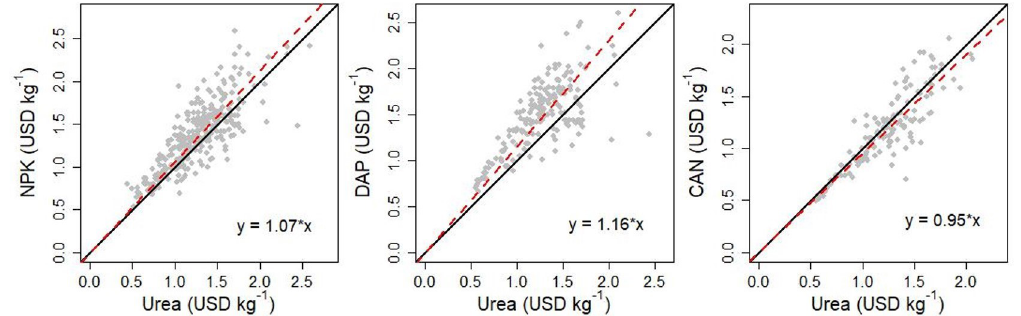
Fig 3. NPK price (USD kg -1 ) versus urea price (USD kg -1 ); DAP price (USD kg -1 ) versus urea price (USD kg -1 ); CAN price (USD kg -1 ) versus urea price (USD kg -1 ) for each location where both prices were reported. All the prices are non- subsidized. The black line represents y = x . The red line represents the fitted